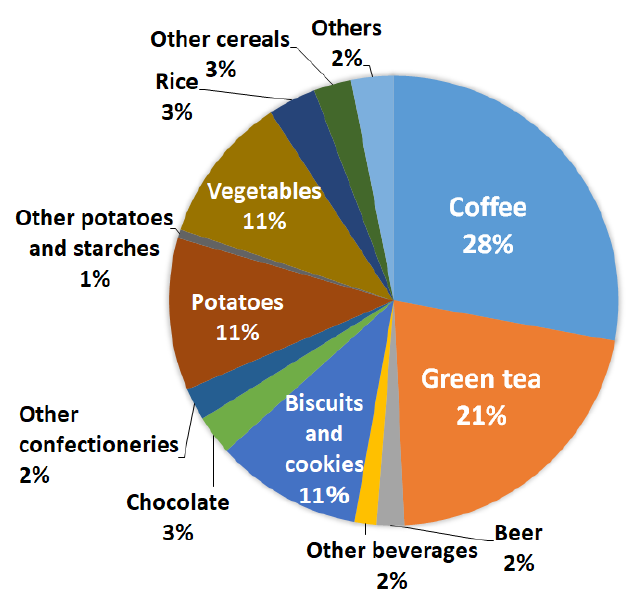
Figure 2. Percentage contribution of acrylamide-containing foods to dietary acrylamide intake.